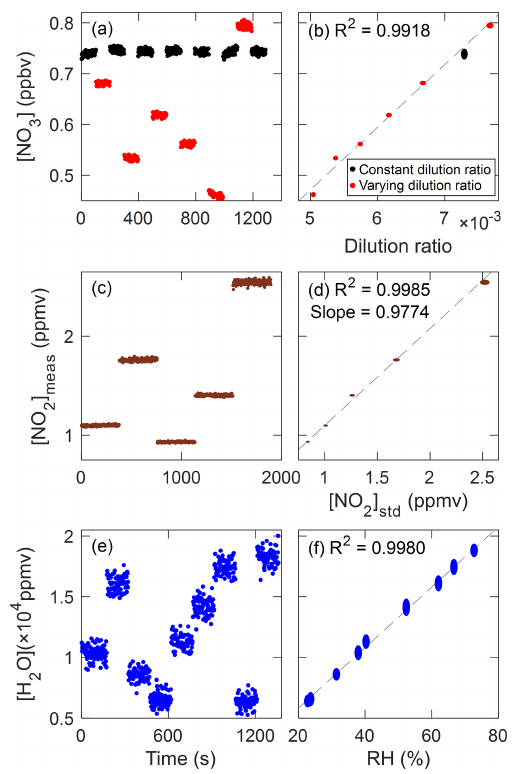
Figure 7. NO 3 (a, b) , NO 2 (c, d) , and H 2 O (e, f) mixing ratios with elapsed times and other independent abundance evaluation parame- ters in standard addition experiments. For NO 3 , data with constant (black) and varying (red) dilution conditions were corrected for the steady drift in NO 3 source by linear interpolation (Fig. S2). In (b) , (d) , and (f) axes of the ellipses represent 1 σ variability for 2s inte- gration data (vertical) and uncertainty of each variable (horizontal), while dashed lines show linear